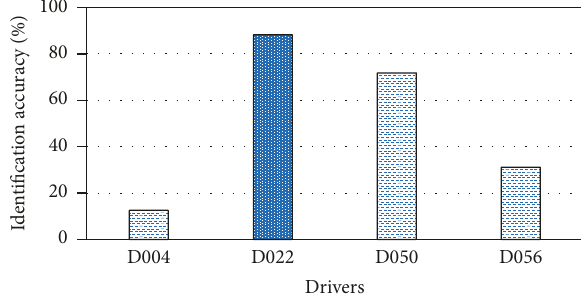
Figure 7: Identification accuracy obtained in a group of drivers with low skills and similar